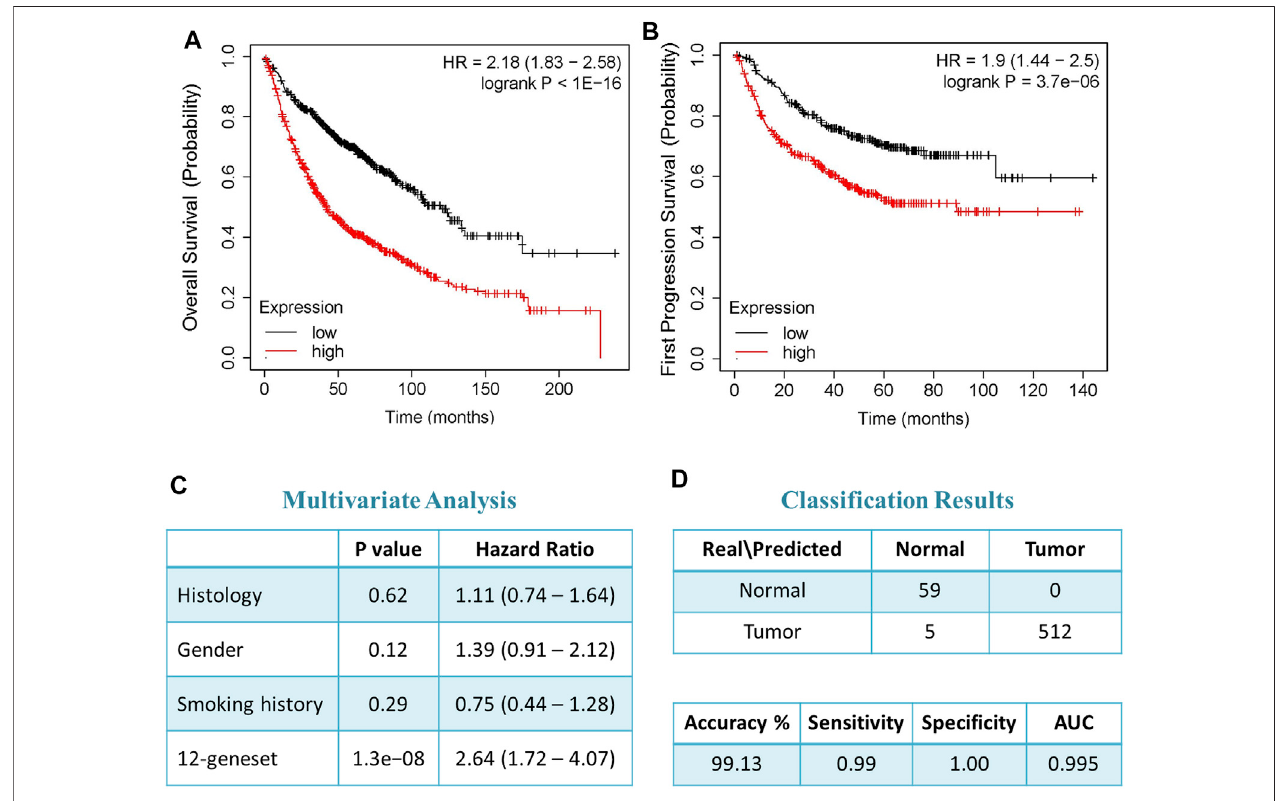
FIGURE 3 | Prognostic signi fi cance of the 12-gene signature. (A) Overall and (B) progression free survival (PFS) analysis using NSCLC tumor samples ( n = 1,144 samples). (C) Multivariateanalysisusinghistology(adenocarcinomaandsquamouscellcarcinoma),gender,andsmokinghistoryascovariates. (D) Classi fi cationresults of our gene signature using nearest centroid with proportional prior probability